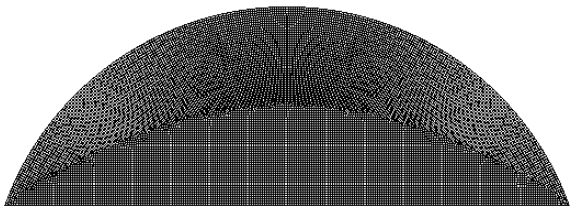
Fig. 2. Computational grid for the 35 o pitch enclosure.